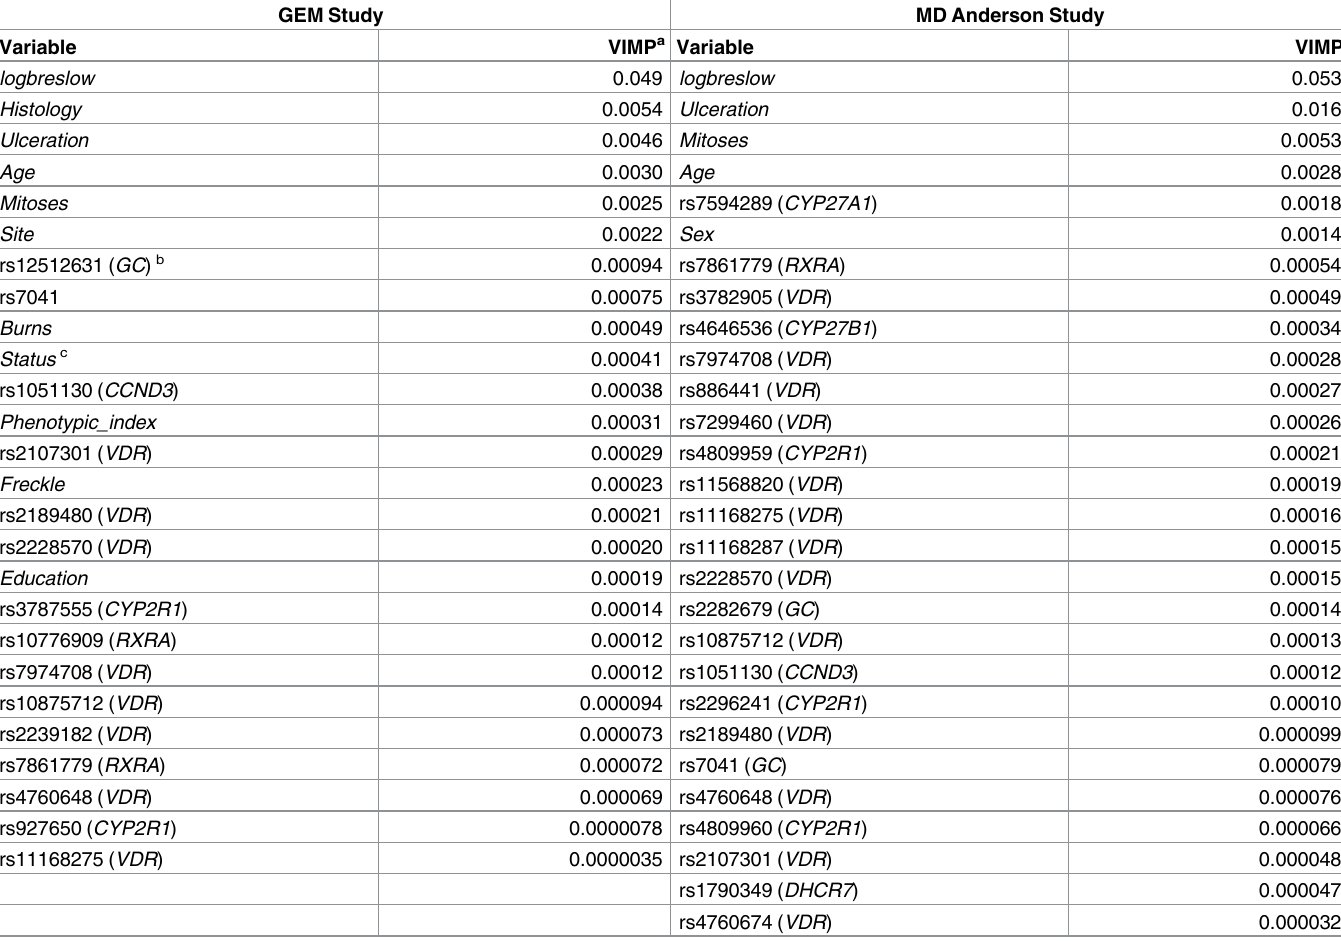
Table 3. The clinical, demographical variables and genetic variants selected by Random Survival Forest (RSF) ordered based on the variable importance (VIMP) prediction measurein the secondary analysis of GEM study by including additional prognostic